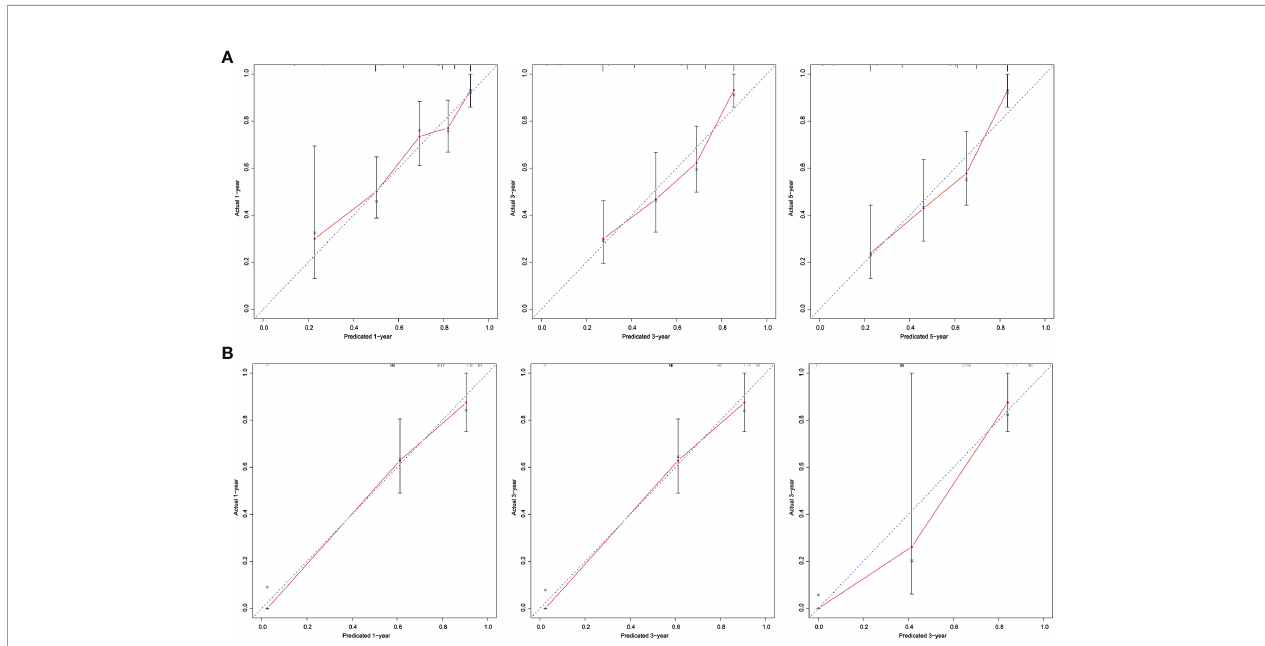
FIGURE 4 | The red solid line represents the performance of the nomograph, and the higher the fi tting degree with diagonal dotted line, the better the prediction effect. (A) Derivation cohort; (B) Validation